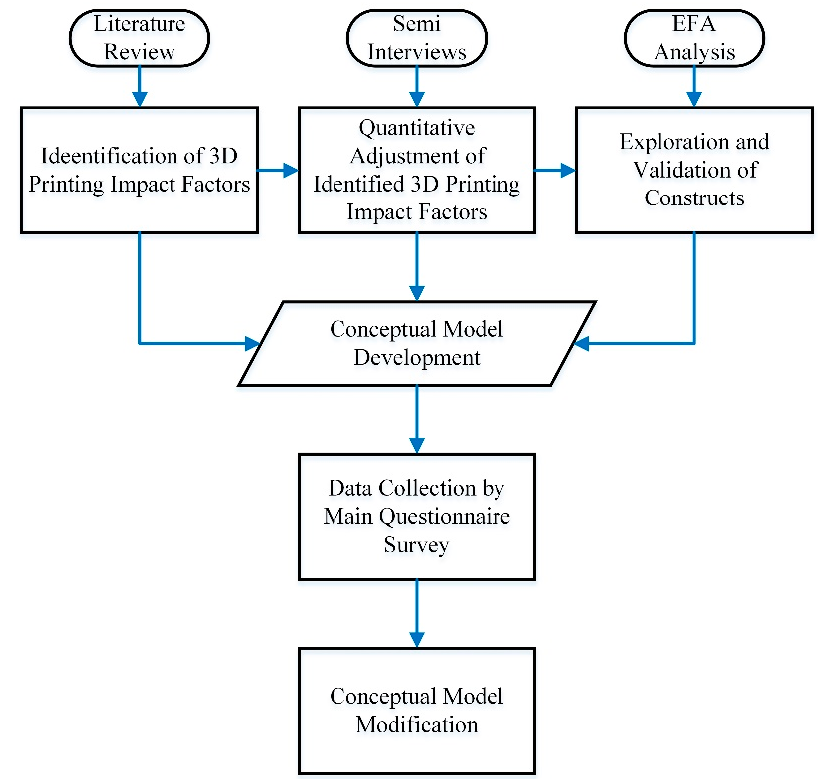
Figure 2. Research methodology flowchart.